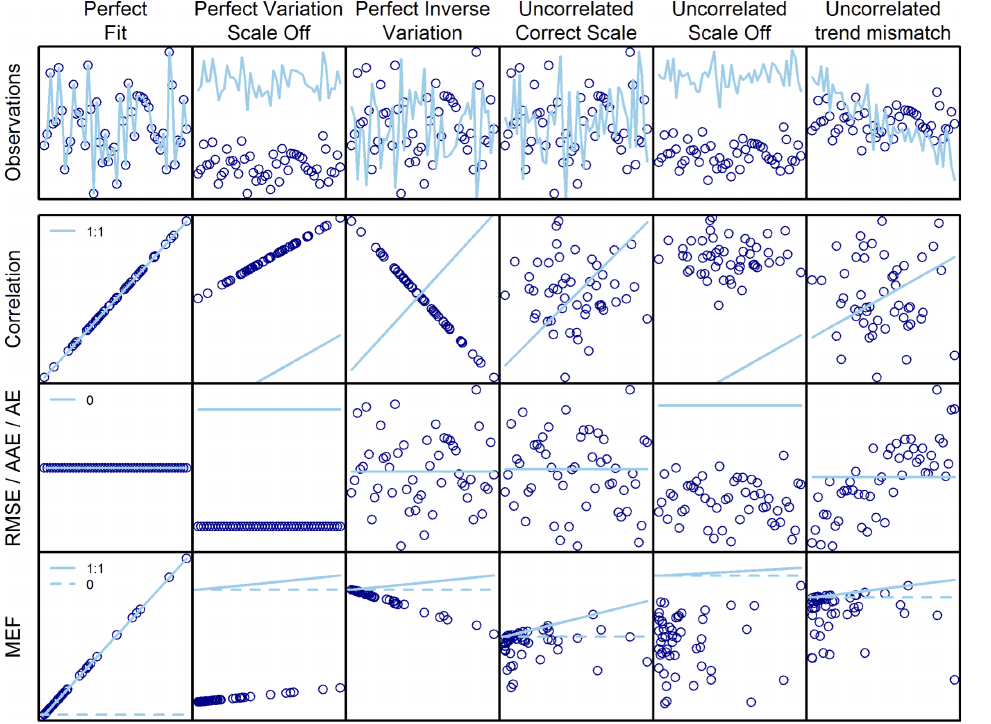
Fig 1. Conceptual Fig comparing the skill metrics (RMSE, AAE, AE, MEF and correlation) performance using simulated observed (open circles) and modeled data (lines).